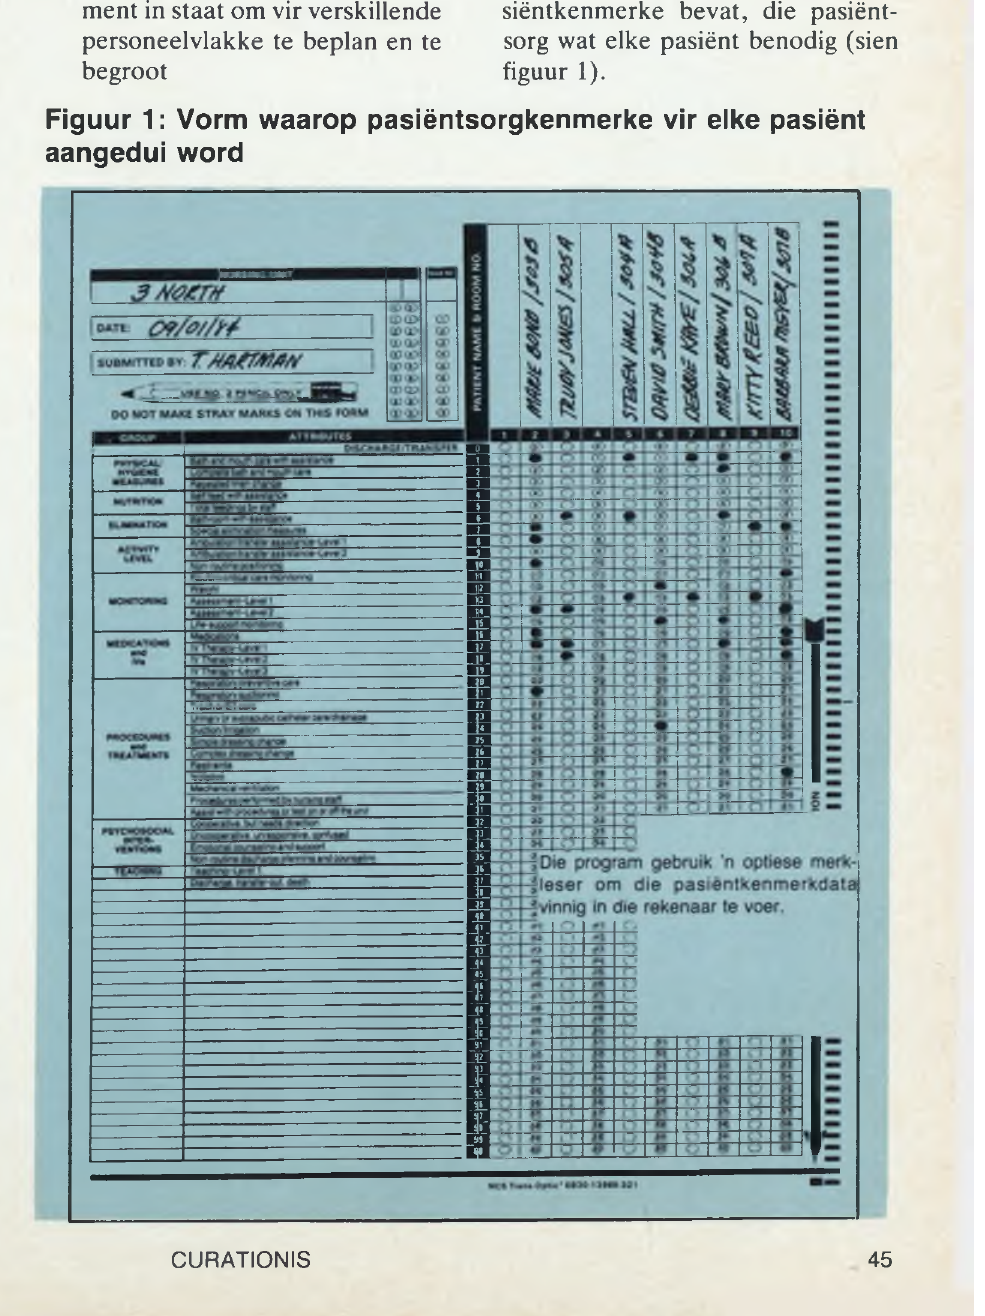
Figuur 1: Vorm waarop pasiëntsorgkenmerke vir elke pasiënt aangedui